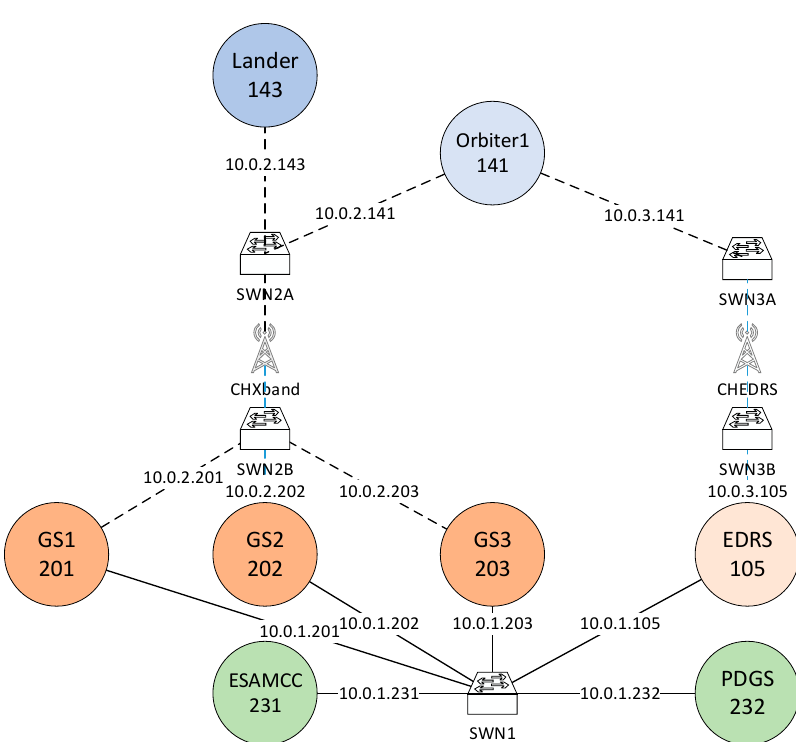
Figure 7. The layout of the Virtualbricks testbed used in experiments.